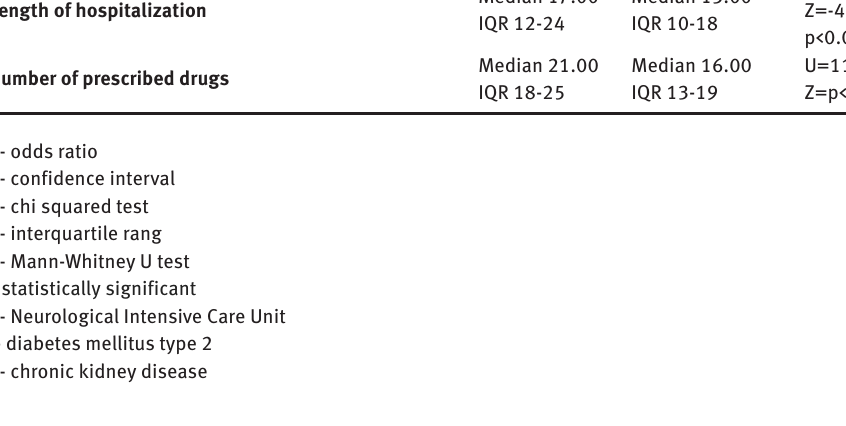
Table 4B: Type of therapy and potential drug-drug interactions (pDDI) characteristics of cases and